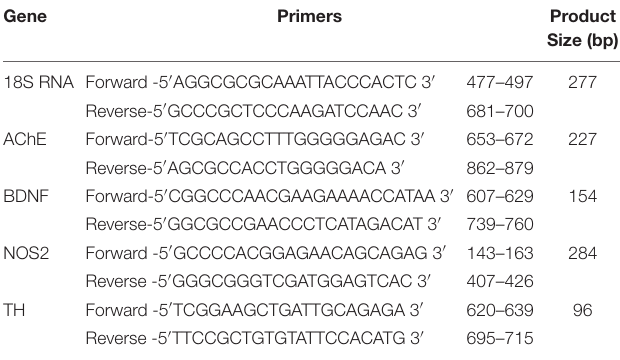
TABLE 1 | Primers sequences used for quantitative PCR. Gene Primers Product